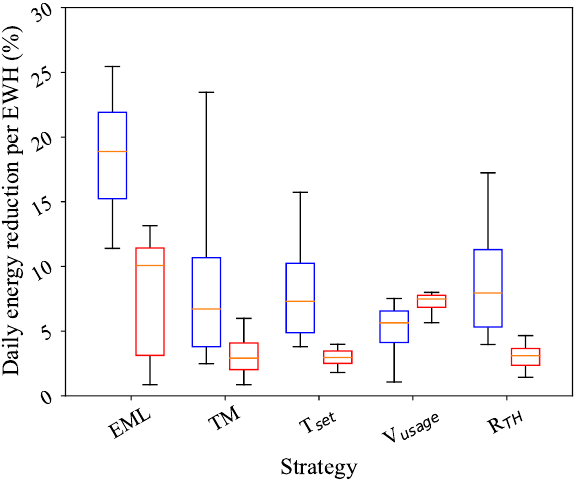
Figure 3. Box plot showing the distribution of the daily reduction in energy consumed (as a per- centage) by light- (blue) and heavy-usage (red) EWHs compared to that produced by the baseline energy consumption for T set (set to 60 °C), V usage (10% reduction), and R TH (thermal blankets and pipe